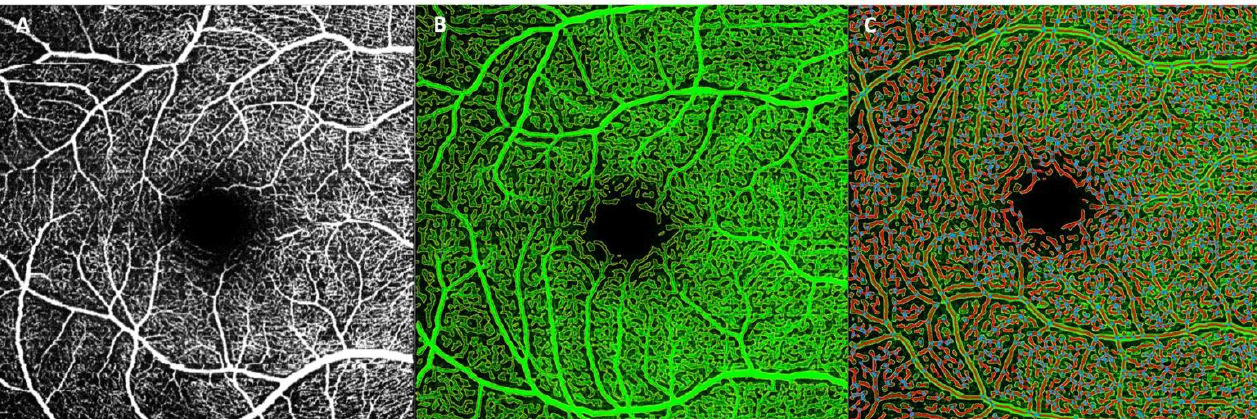
Figure 3. Image analysis using AngioTool software. ( A ) An OCTA image extracted from the Heidelberg image viewer in TIFF format and cut out for analysis. ( B ) The segmentation and skeletonization of vessels. ( C ) An image resulting from the analysis showing an overlay indicating the area encom- passing all vessels, a skeletal representation of the vascular network and the calculated branch points within this